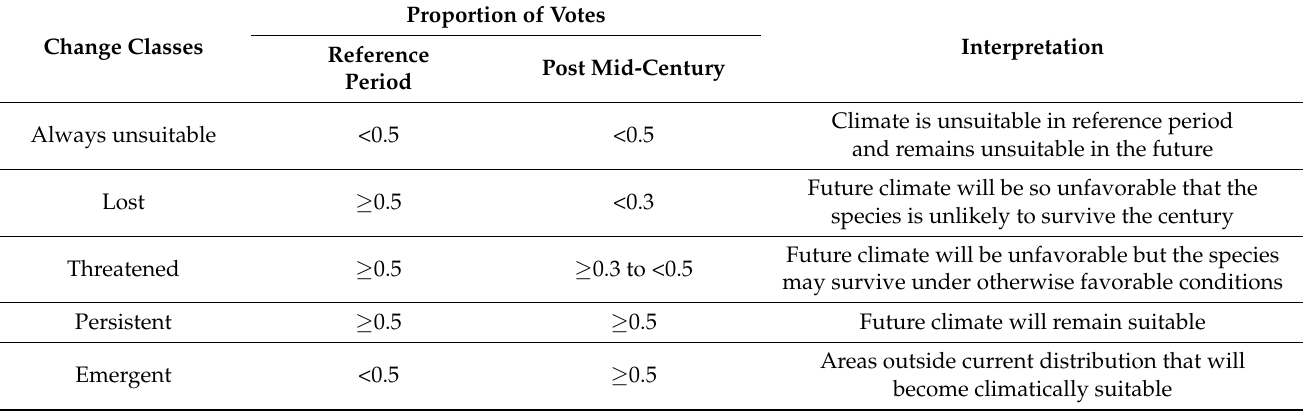
Proportion of Votes